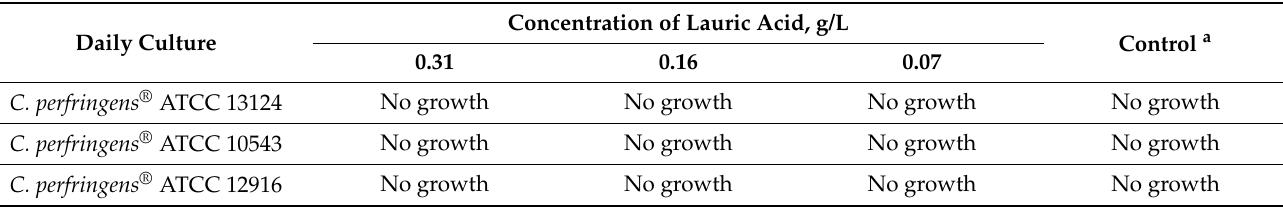
Table 3. Growth suppression of C. perfringens strains by lauric acid at different concentrations.